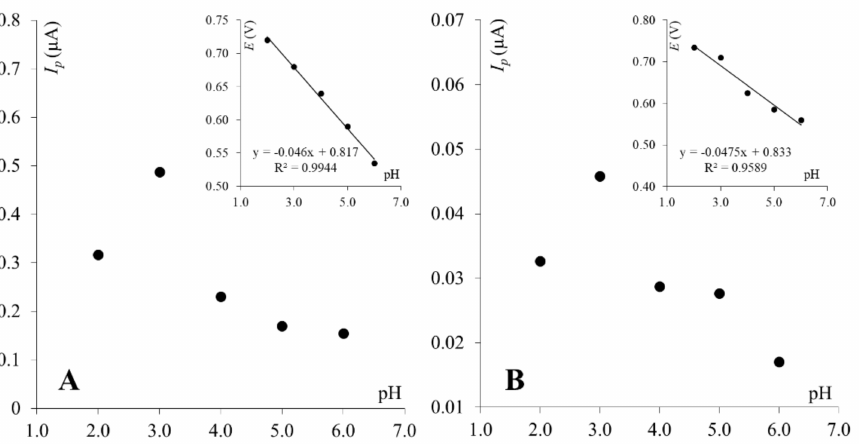
Figure 4. Dependence between PA peak currents and pH of BR buffer for ClPE ( A ) and GrPE ( B ). Insets: dependence between PA peak potentials and pH of BR